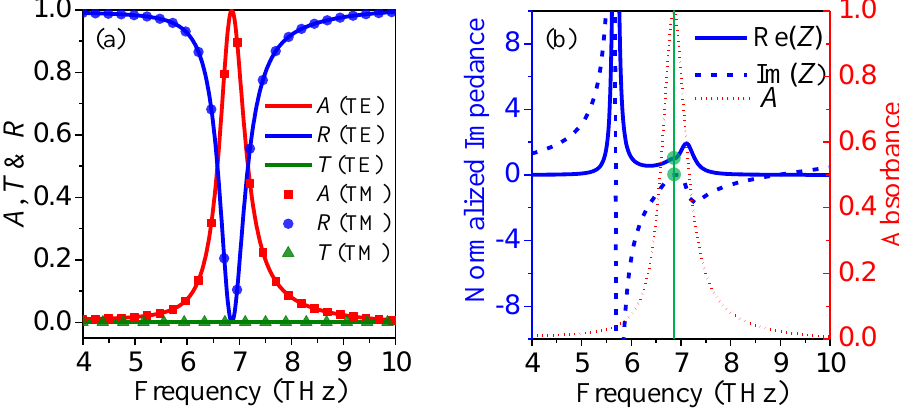
Figure 2. ( a ) Simulated absorbance ( A ), transmission ( T ), and reflectance ( R ) of the proposed absorbers with SLDGRAs for both transverse magnetic (TM) and transverse electric (TE) polarizations at μ c = 0.3 eV under normal terahertz incidence; ( b ) The real and imaginary parts of the retrieved effective impedance ( Z ) of the absorber for both TM and TE polarization, where the black and red curves indicate the Re( Z ) and Im( Z ), respectively, and the vertical green solid cut-line denotes the frequency of absorbance peak at 6.85 THz.